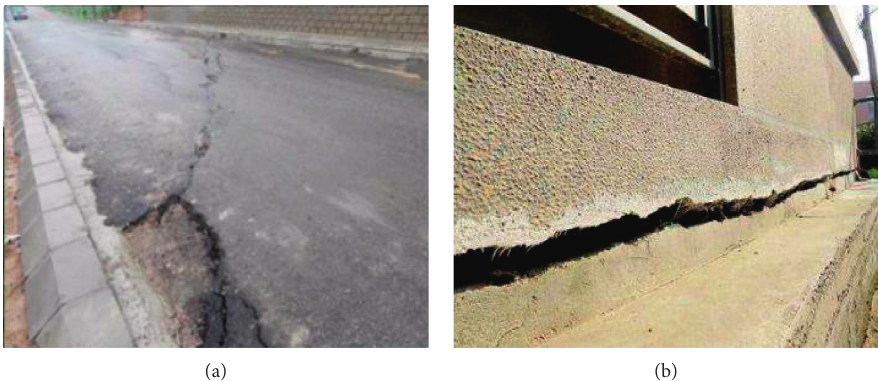
Figure 1: Secondary disasters caused by uneven settlement of foundation after fill engineering. (a) Road cracking caused by subgrade settlement of the high-fill section. (b) Wall cracking caused by uneven foundation